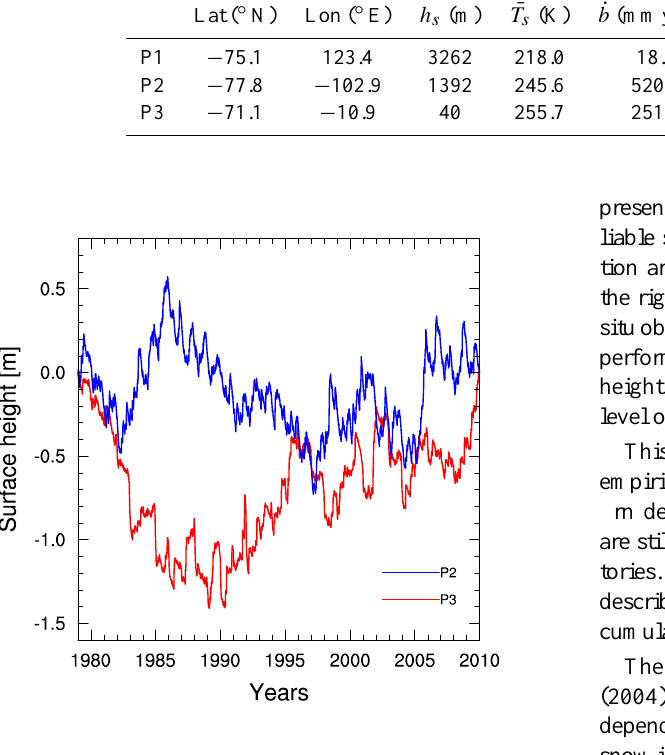
Fig. 10: Surface height evolution (1979–2009) for P2 and P3 (see Fig.